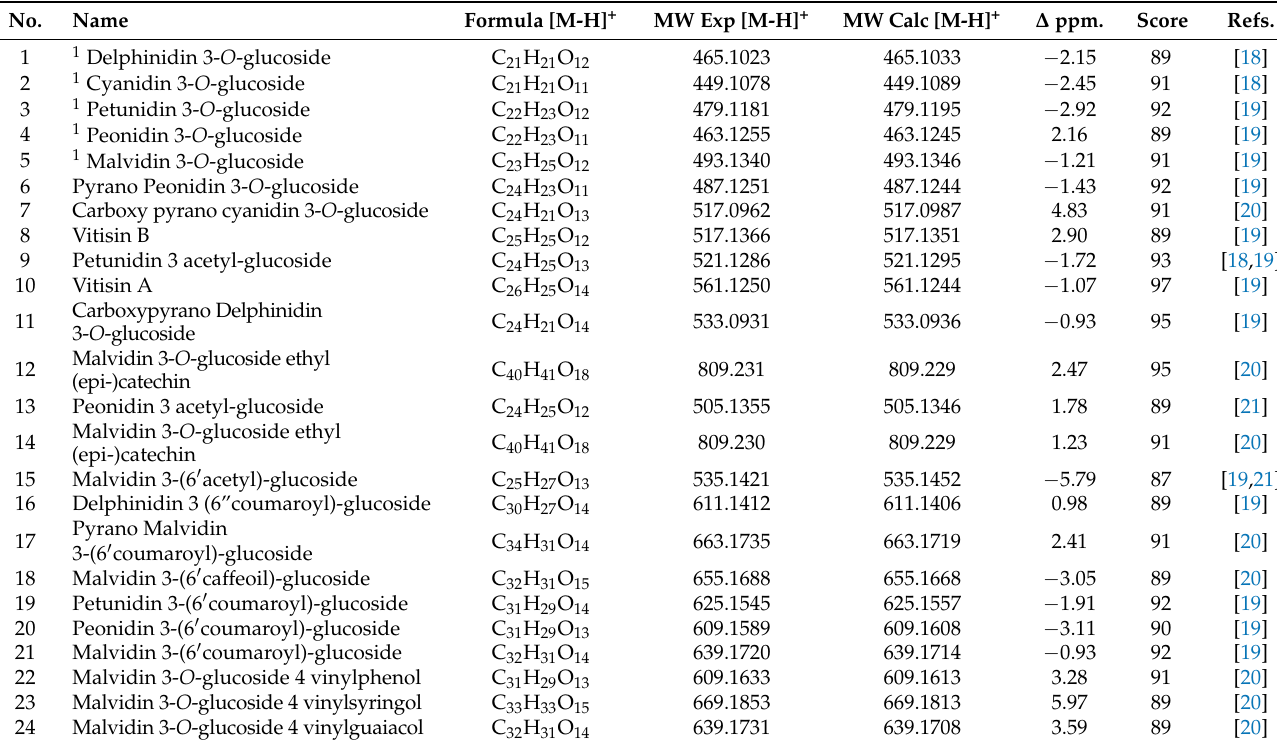
Table 2. Anthocyanins [M-H] + identification attempt by HPLC/DAD/TOF analysis in the grape marcs analyzed. No.